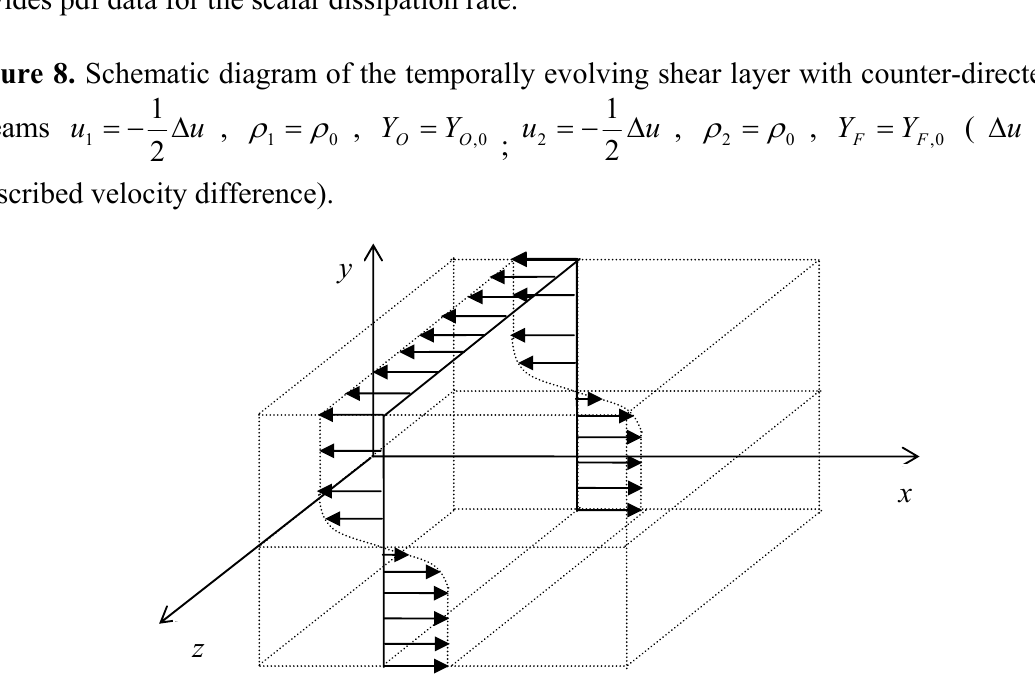
Figure 8. Schematic diagram of the temporally evolving shear layer with counter-directed 21 streams uu Δ−= 1 prescribed velocity